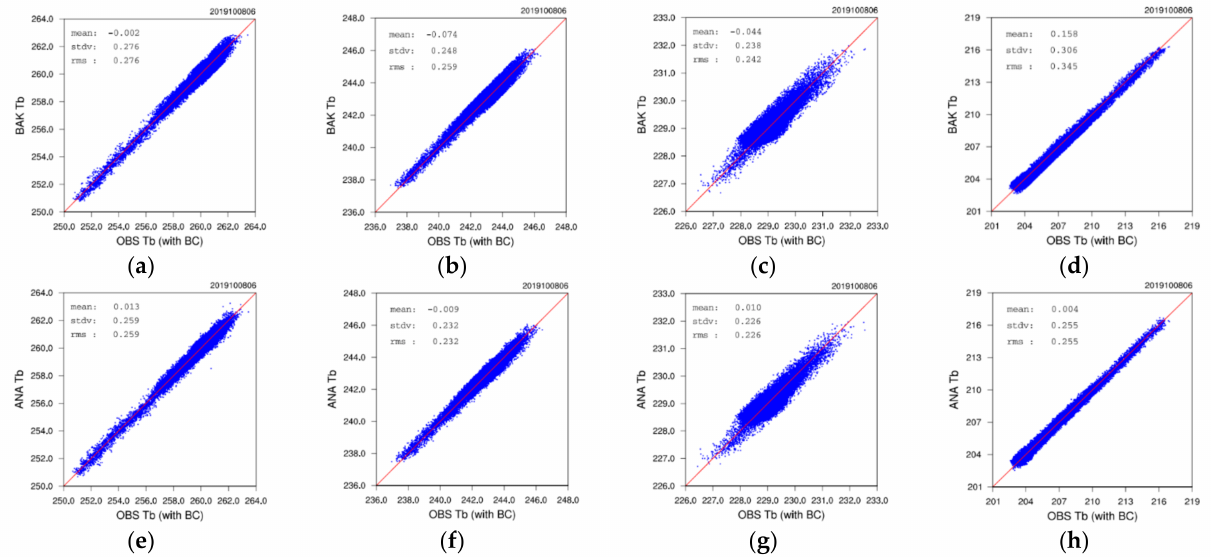
Figure 11. Scatter plots of model-calculated brightness temperature versus the observations (K) of GMR for ( a – d ) background and ( e – h ) analyses valid at 06:00 UTC on 8 October 2019. ( a , e ) represents channel-4 53.596 GHz, ( b , f ) represents channel-5 54.4 GHz, ( c , g ) represents channel-6 54.94 GHz, and ( d , h ) represents channel-8 57.29 GHz.